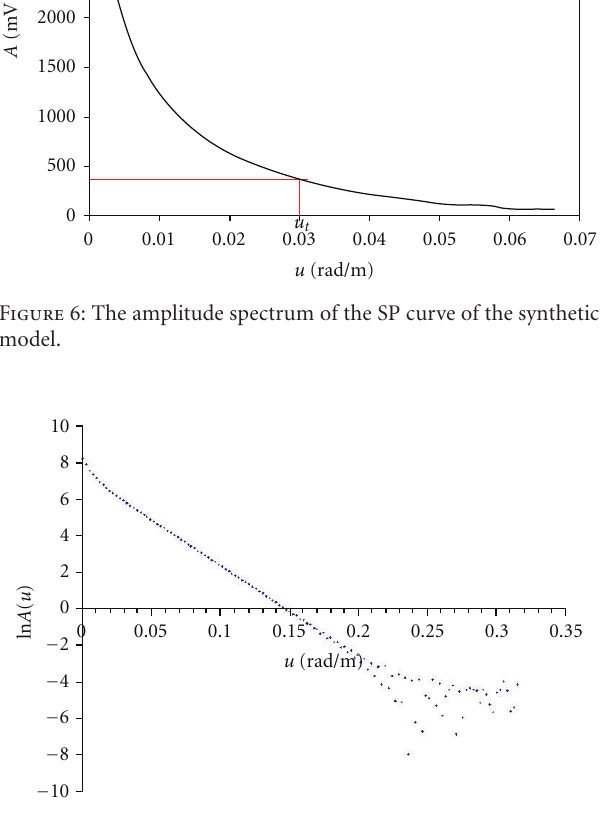
Figure 7: The natural logarithm of the amplitude A against spatial frequency u .